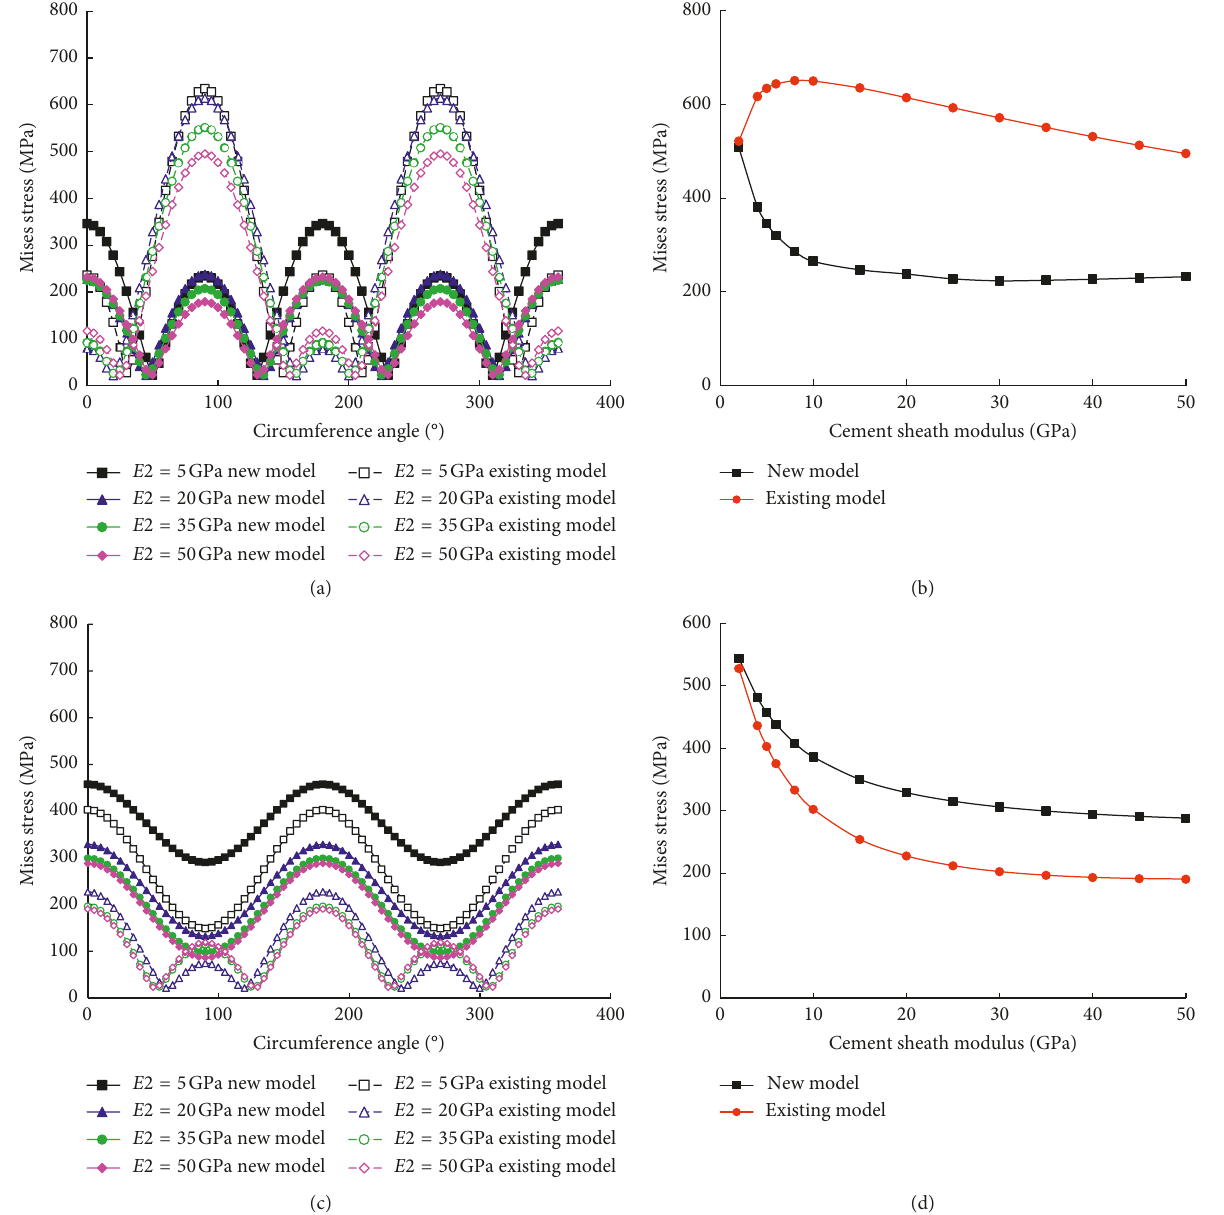
Figure 16: Casing Mises stress. (a, b) E